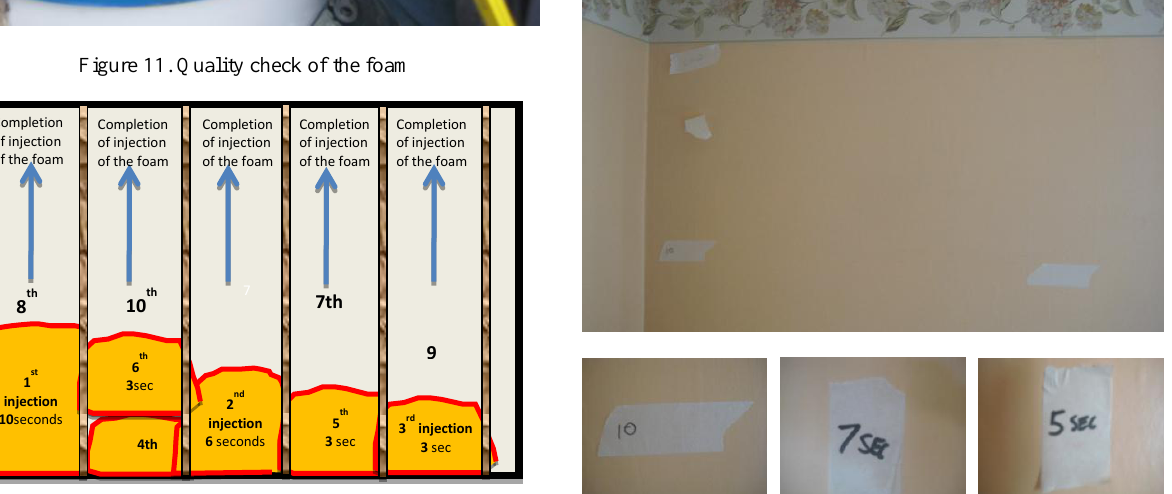
Figure 12. Injection of the foam in the bays in alternative way